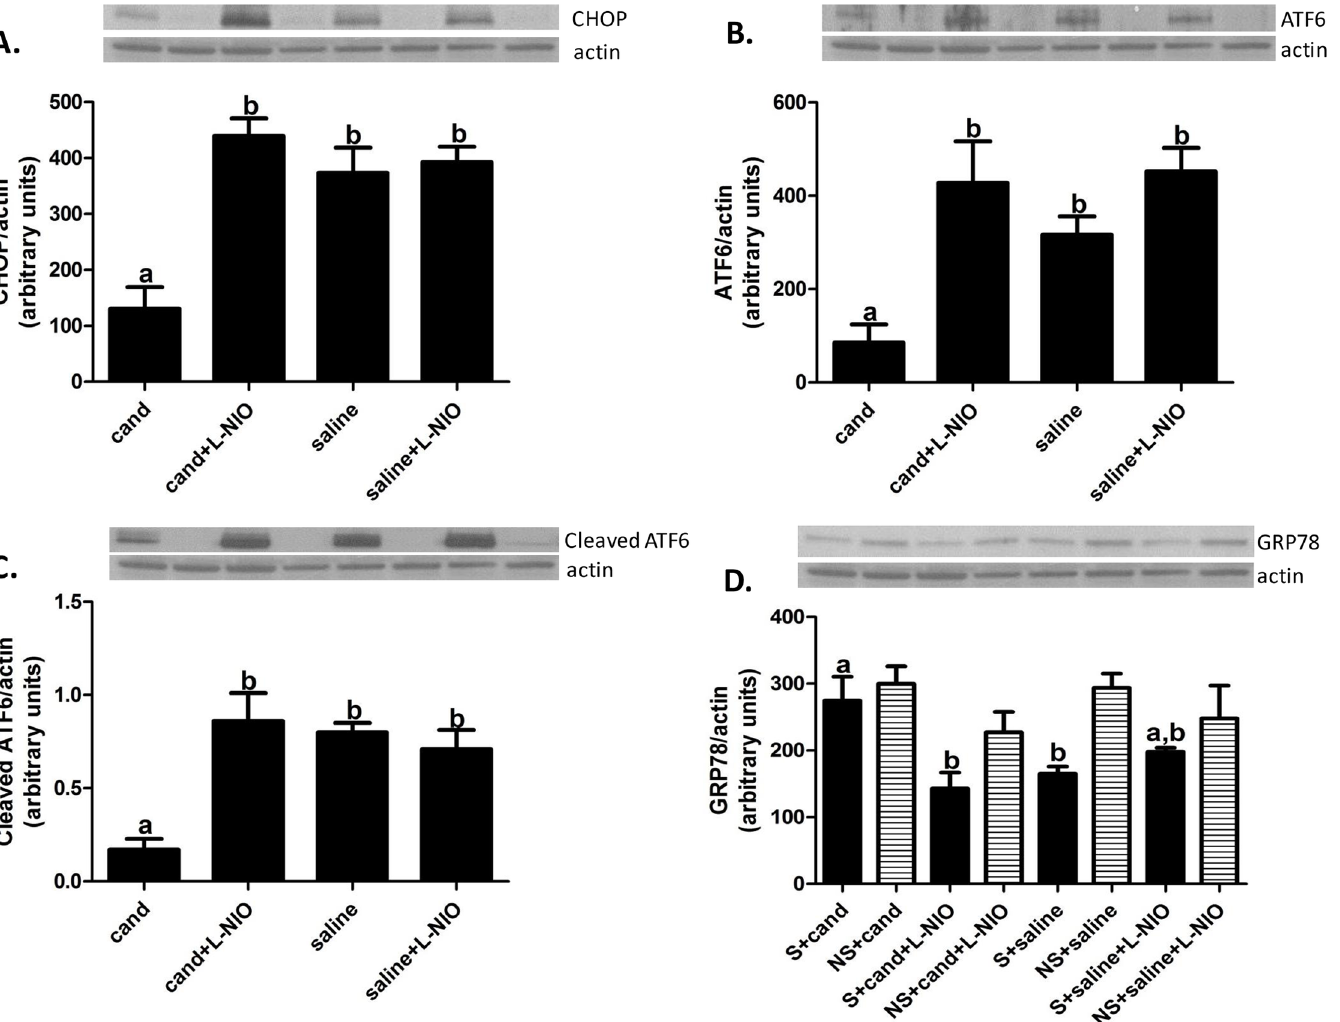
Fig 5. Early AT1 blockade ameliorates ischemia-induced increasein ER stress. Candesartan treatment at time of reperfusionreducedthe expression of CHOP (F = 12.52, df = 3: p = 0.0007) (A), cleavedATF6 (F = 7.88; df = 3; p = 0.0044) (C) and increasedGRP78 expressionin an eNOS dependent manner (F = 6.433, df = 3; p = 0.0089)(D).eNOS inhibitionincreasedthe expressionof full length ATF6 (F = 8.264, df = 3; p = 0.0078) (B) Data presented as mean ± SEM.Solid columns representipsilateralhemisphere, columns with stripes represent contralateralhemisphere. S refers to the ipsilateral hemisphere; NS refers to the contralateralhemisphere. a, b Pairs of means with different letters are significantlydifferent from each other * n = 4 per group.